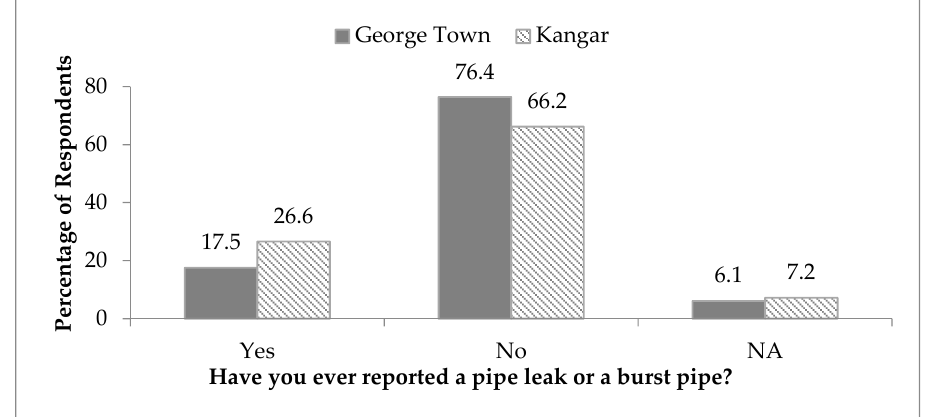
Figure 7. Percentage of respondents that saved phone number of water utilities in their mobile phone. Water 2017 , 9 , 26